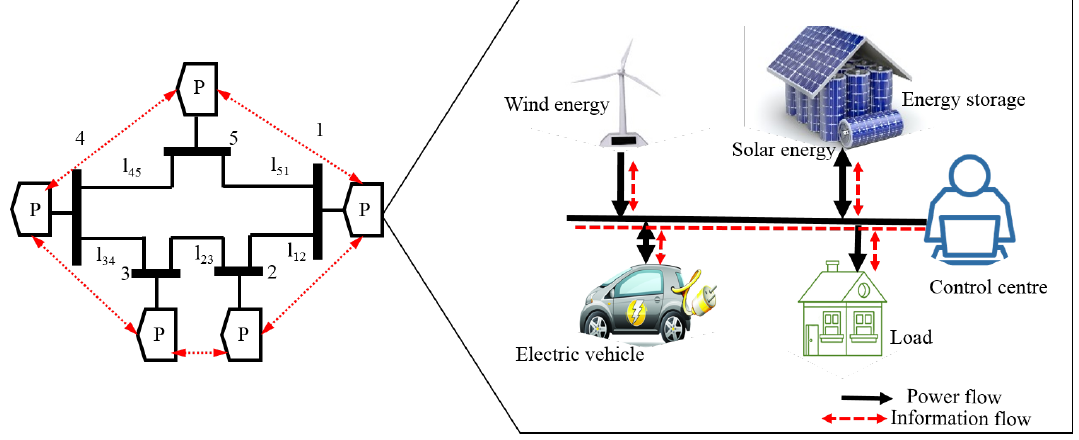
Figure 1. An example of IEEE five-bus system showing the composition and connectivity of prosumers